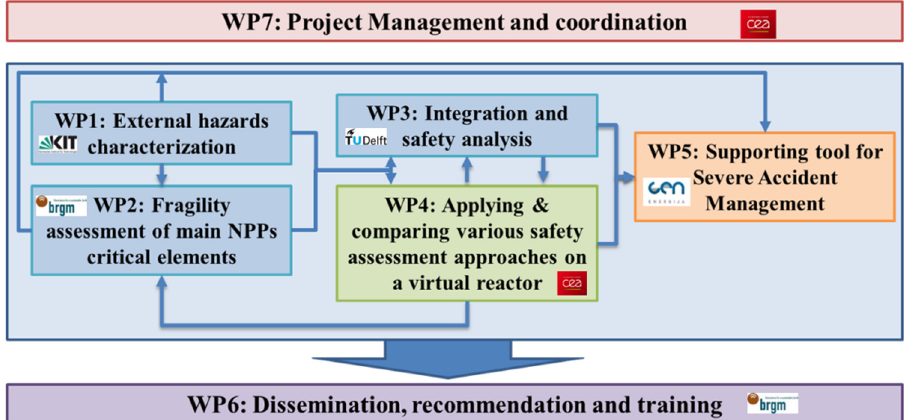
Fig. 3. Global work fl ow of the NARSIS project.